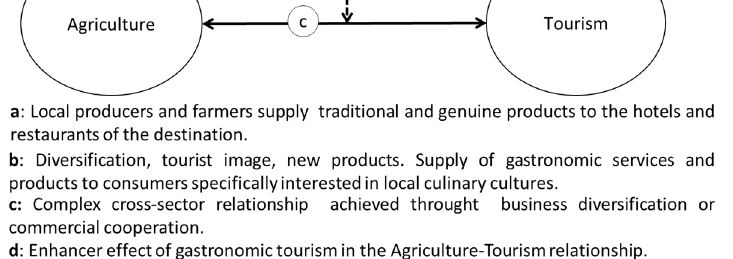
Figure Figure 2. The role of the local gastronomy in the trinomial relationship between agriculture– gastronomy–tourism . Source: own elaboration.